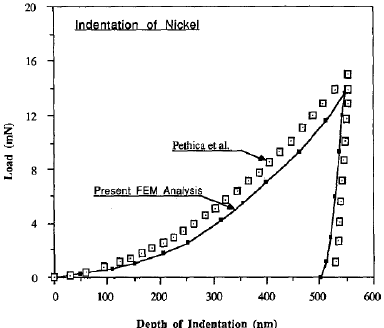
Figure 29. Comparison between the results from the present Finite Element Method (FEM) analysis and those from Pethica et al. [106] on indentation of nickel [104]. Reproduced with permission from